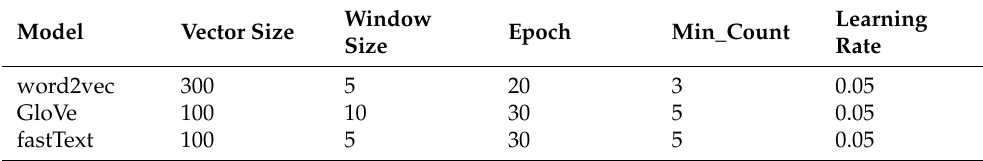
Table 2. Hyper-parameter setting for the different embedding models.